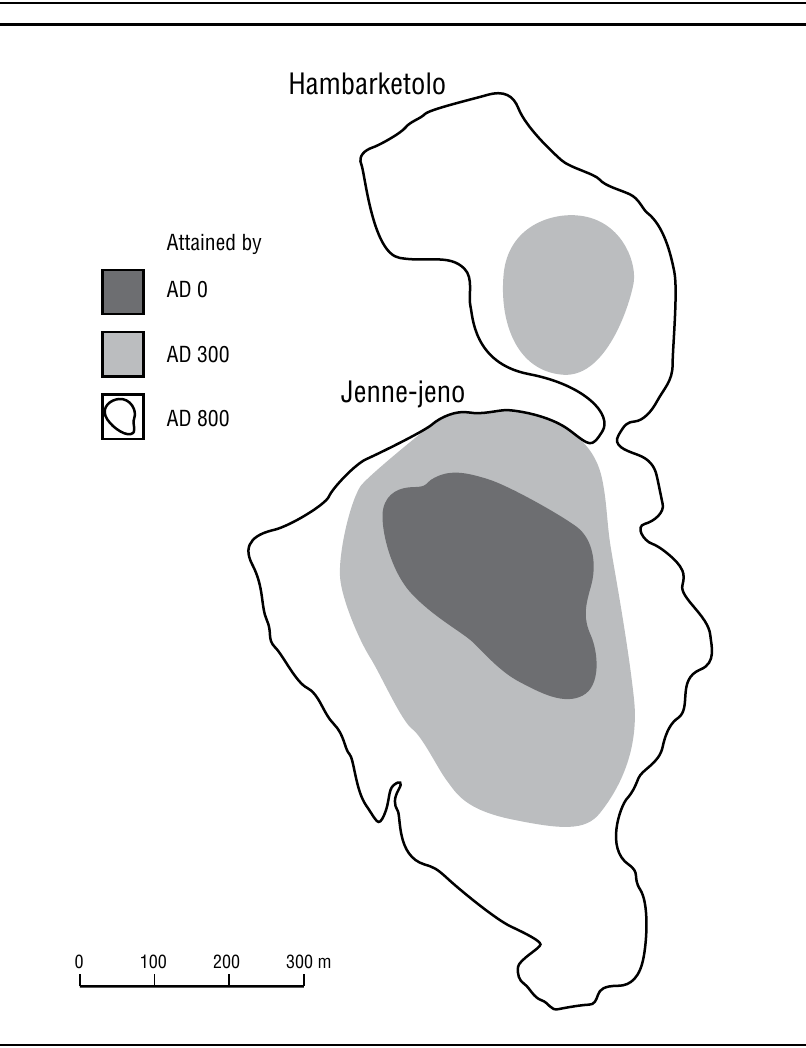
Figure 14 – Plan of Jenne-Jeno